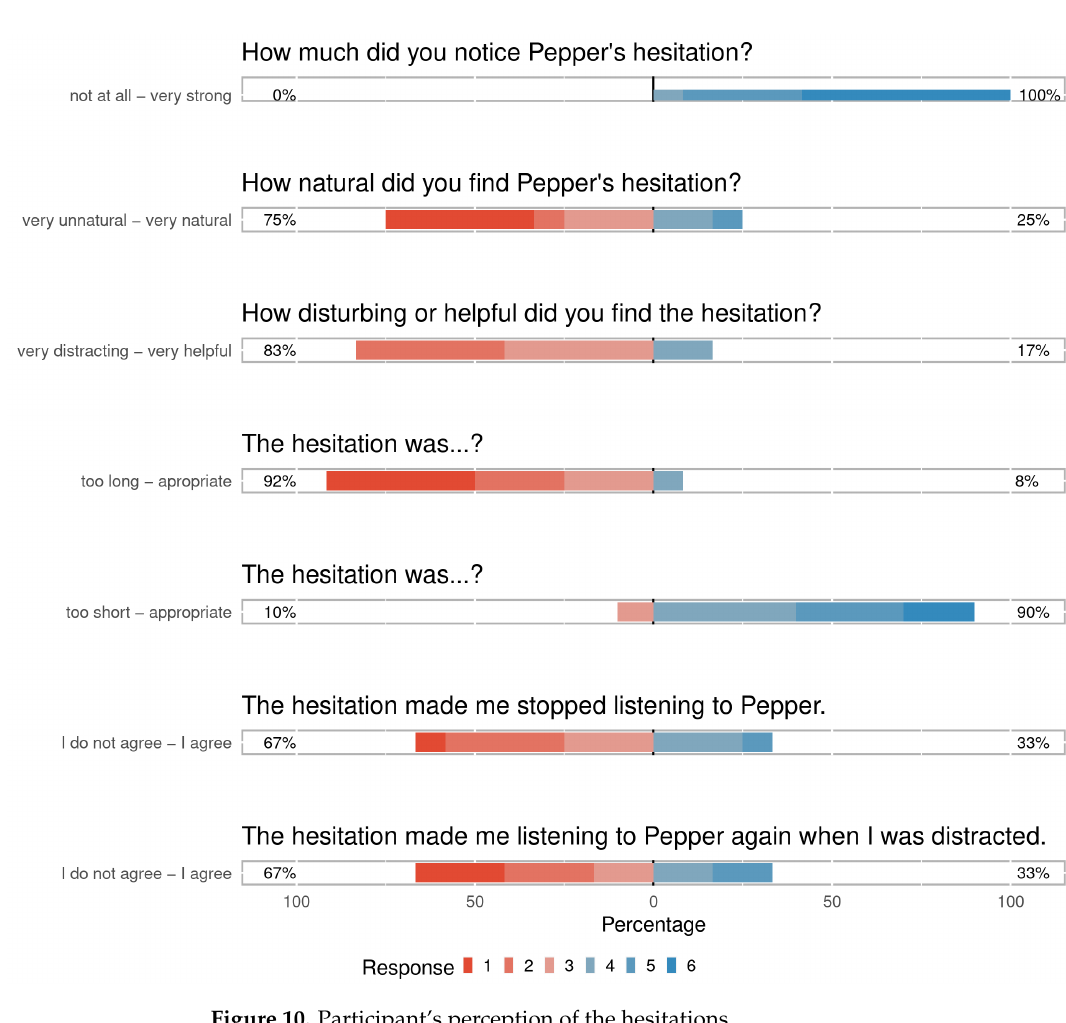
Figure 10. Participant’s perception of the hesitations.